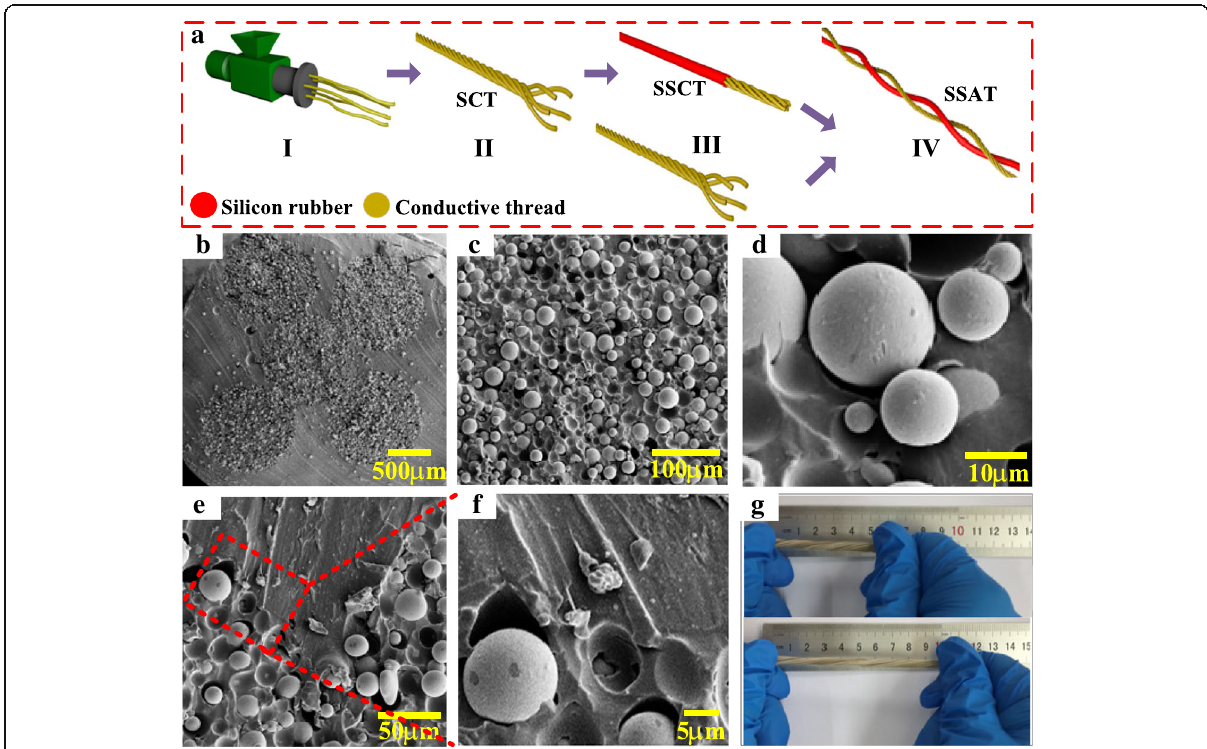
Fig. 1 a Schematic diagram for fabricating process of the SATT device. b – d The SEM image of the SSCT cross-section view at different magnifications. e , f The SEM image of the connection position between SCT and coated silicone rubber at different magnifications. g Photographs of the prepared SATT with demonstrations of being stretched at ≈ 100%